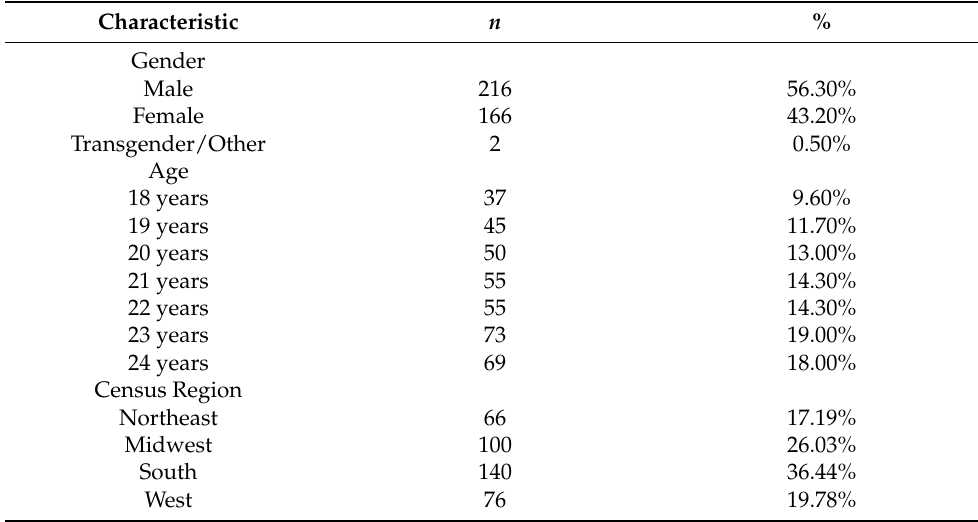
Table 1. Sample characteristics: gender, age, and U.S. census